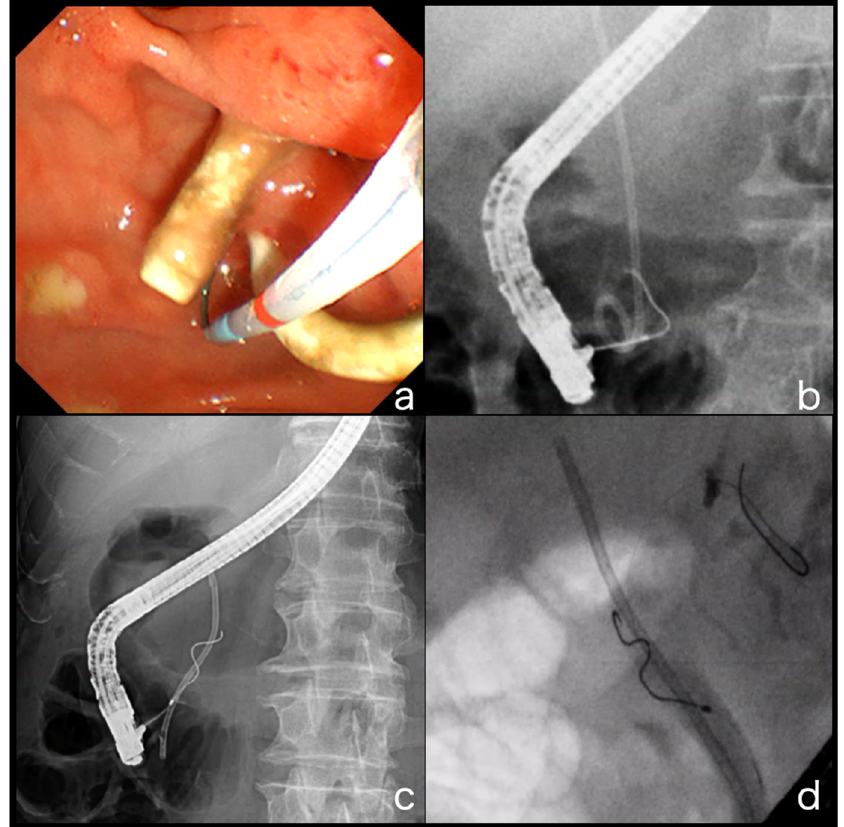
Figure 3. The difficulty of inserting the GW into the bile duct where the PS is inserted. ( a , b ) In the case where a PS is placed, the bile duct cavity beside the PS is very narrow, making it physically difficult for the GW to pass through. ( c , d ) The situation is even more serious in the presence of bile duct stenosis. The space beside the inserted PS is narrower than that of the conventional bile duct stenosis, and instances in which the GW cannot pass through are often encountered. stenosis, and instances in which the GW cannot pass through are often